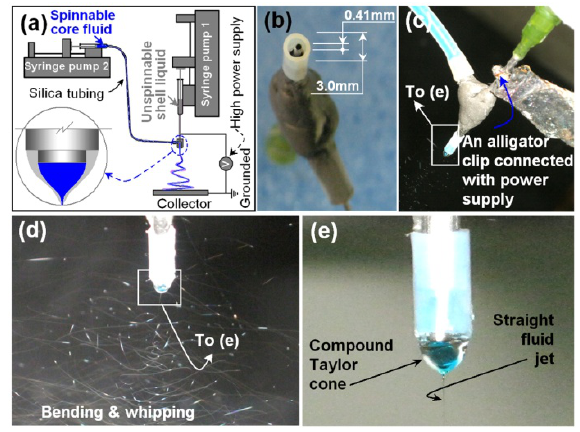
Figure 1. Implementation of the modified coaxial electrospinning processes using a concentric Teflon spinneret. ( a ) A diagram of the modified coaxial process; ( b ) Digital images of the homemade concentric Teflon-coated spinneret; ( c ) Connection of the power supply with spinneret; ( d and e ) Observations of the coaxial electrospinning processes: a typical fluid jet traveling process and a typical compound Taylor cone under a voltage of 15 kV and at a fiber collected distance of 20 cm for fabricating nanofibers F4.